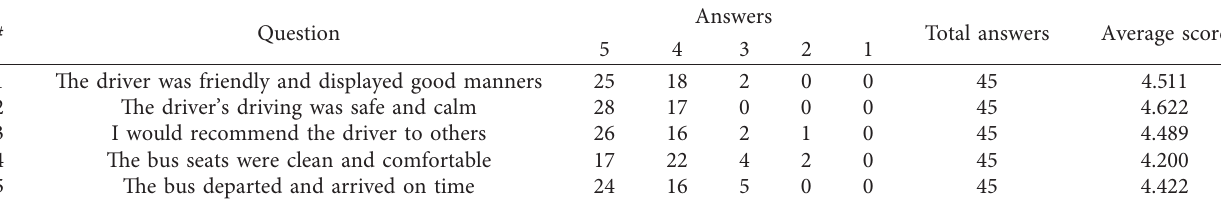
Table 2: The trip satisfaction survey results.